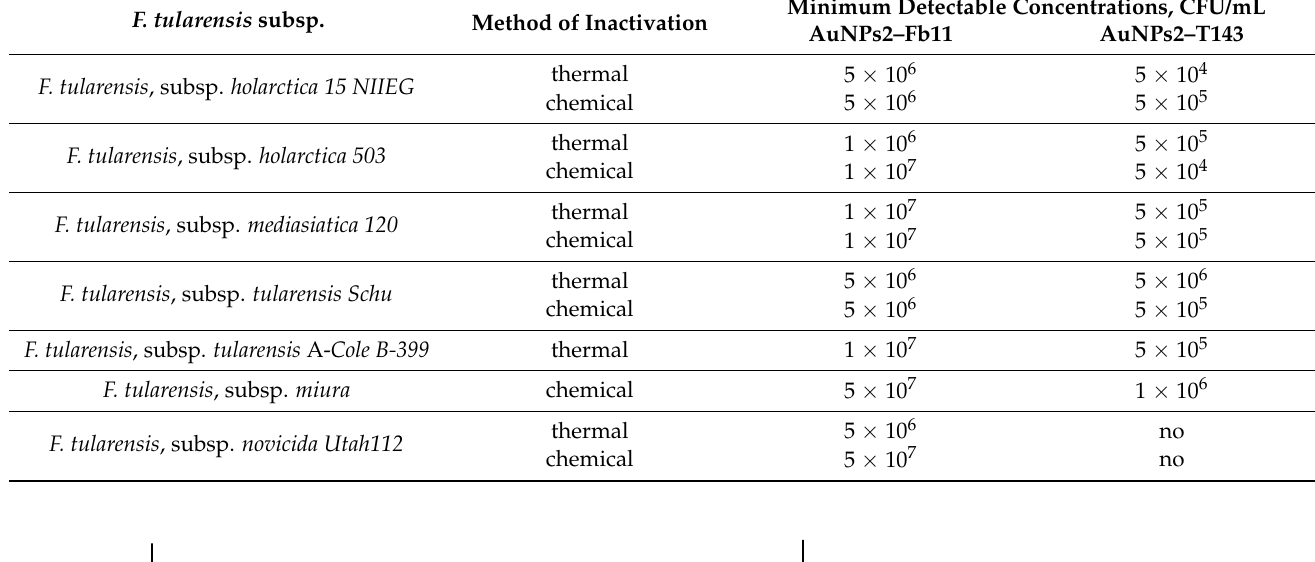
Table 5. Minimum detectable concentrations of F. tularensis cells in the agglutination reaction with AuNPs2–Fb11 and AuNPs2–T143 conjugates.